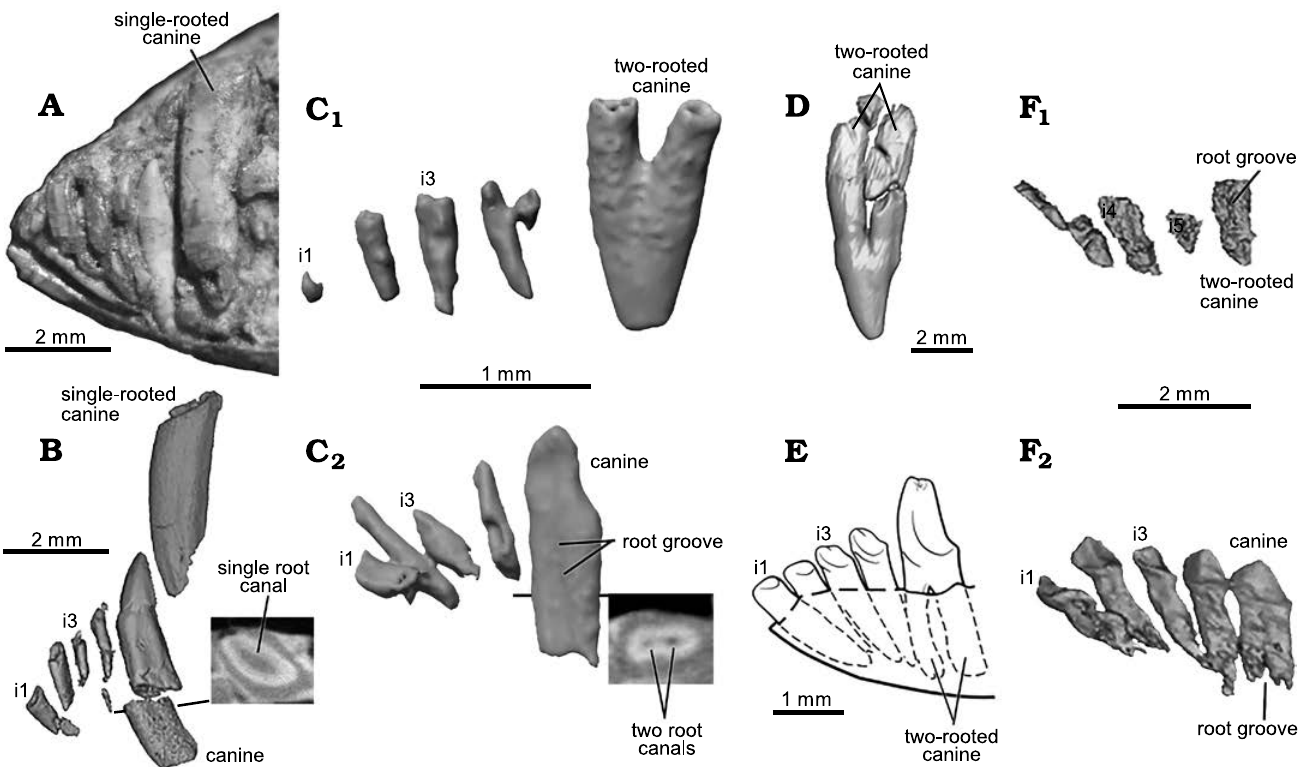
Fig. 9. Comparative morphology of incisors and canine among mammaliaforms. A , B . The morganucodontan Morganucodon oehleri Rigney, 1963, from the Lower Lufeng Formation, Lower Jurassic of China. A . CUP-FMNH 2320, type specimen. B . BMNH 2858, whole tooth and oblique-horizontal slice to visualize the single root canal. C . The mammaliaform Hadrocodium wui Luo, Crompton, and Sun, 2001 (holotype, IVPP 8275) from the Lower Lufeng Formation, Lower Jurassic of Yunnan, China; C 1 , upper incisors and canine; C 2 , lower incisors and canine. D . The docodontan Haldanodon exspecta- tus Kühne and Krusat, 1972 (Gui-Mam 41/75) from the Guimarota Coal Mine, Upper Jurassic of Portugal (Ruf et al. 2013; Huttenlocker et al. 2018). E . The docodontan Docofossor brachydactylus Luo, Meng, Ji, Liu, Zhang, and Neander, 2015b (BMNH 131735) from the Tiaojishan Formation, Upper Jurassic of China (Luo et al. 2015b). F . The docodontan Agilodocodon scansorius Meng, Ji, Zhang, Liu, Grossnickle, and Luo, 2015 (BMNH 00138) from the Tiaojishan Formation, Upper Jurassic of China (Meng et al. 2015b); F 1 , left upper incisors and canine in lingual view; F 2 , left lower